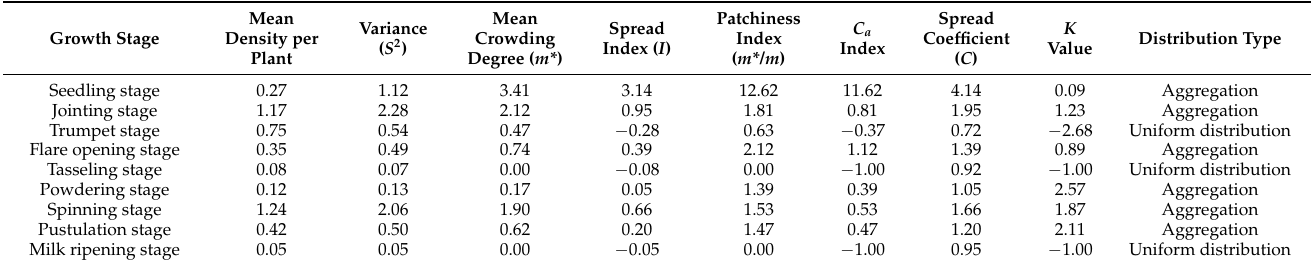
Table 2. Total sample density and aggregation index of Spodoptera frugiperda larvae in mountain maize fields in 2020.